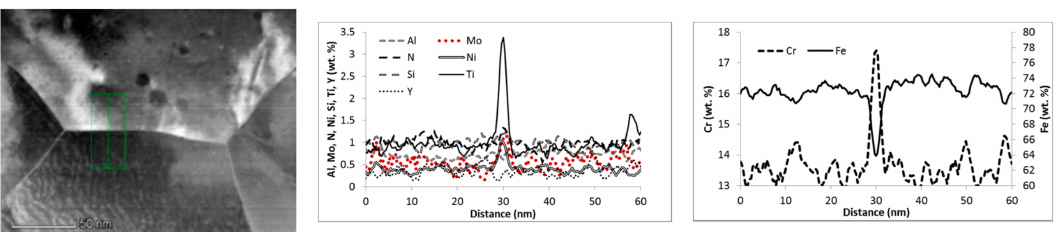
Figure 8. STEM-EDX profile of chemical composition across a grain boundary in the Air720 condition. It shows distinctive enrichment with Ti, Cr, and slight with Mo and Ni at the grain boundary.